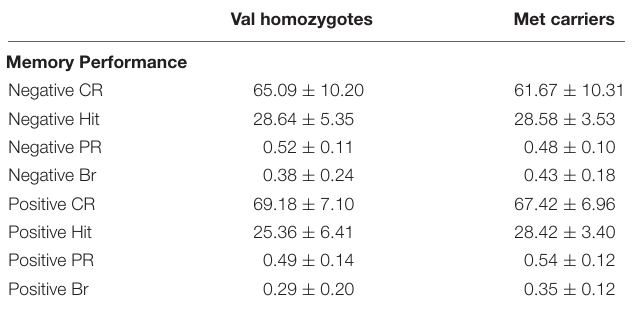
TABLE 4 | Memory performance according to genotype group in Experiment 2. Val homozygotes Met carriers